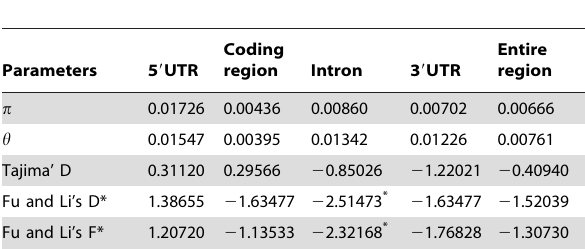
Table 3. Nucleotide and allele diversities of RTCS gene by analyzing 73 maize inbred